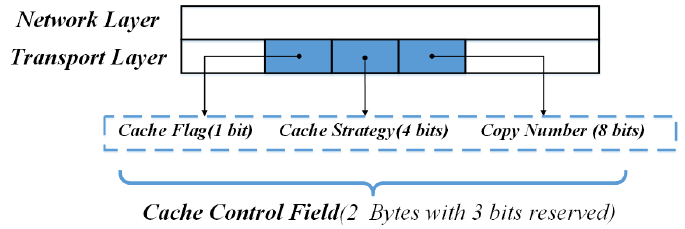
Figure 5. Cache control field design.